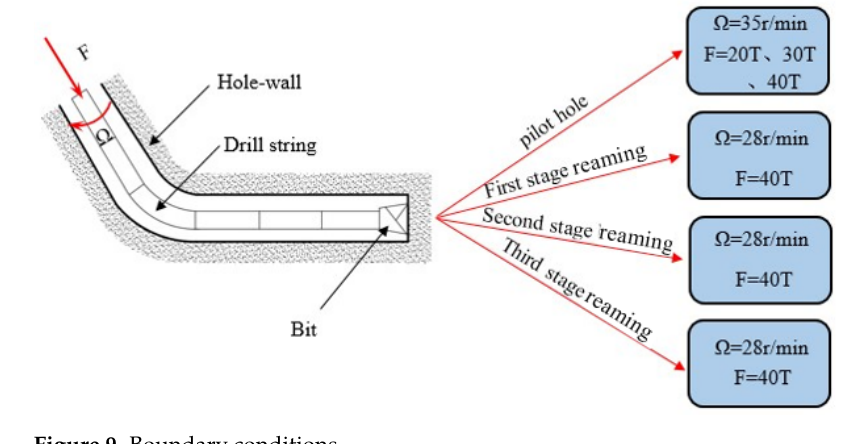
Figure 9. Boundary Figure 9. Boundary conditions. Figure 9. Boundary conditions.